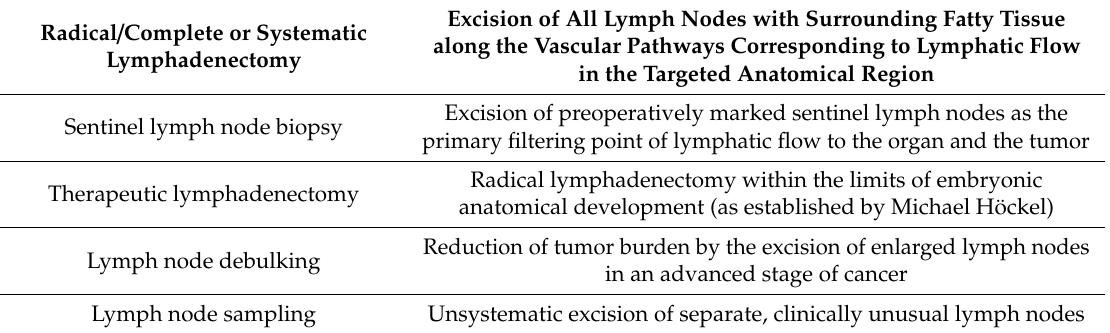
Table 1. Terms associated with